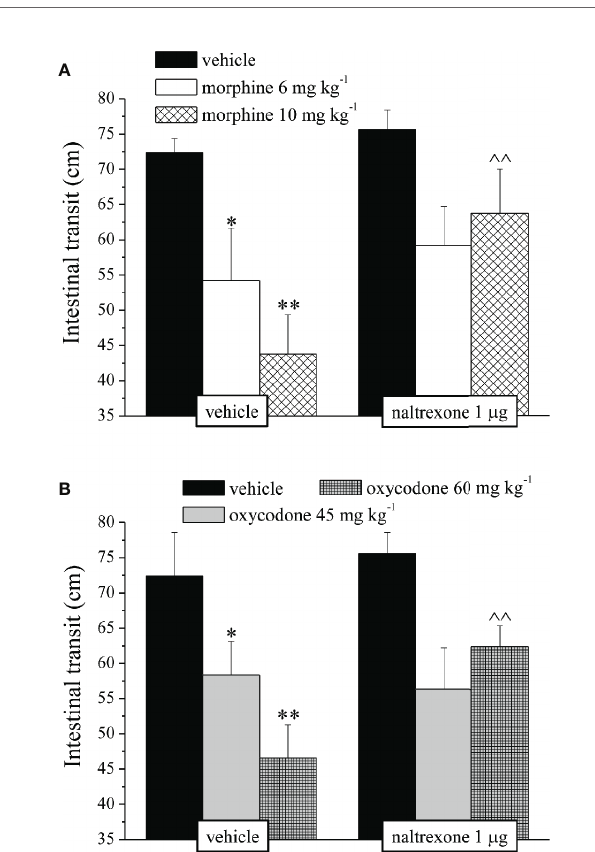
FIGURE 5 | Effect of intranasal administration of naltrexone on morphine and oxycodone induced inhibition of colonic propulsion in the mouse. The propulsion of the distal colon was evaluated by inserting a bead of glass in the distal colon of each animal 30 min after the administration of (A) morphine 10 mg kg − 1 or (B) oxycodone 60 mg kg − 1 . Naltrexone 1 m g was intranasally administered 30 min before the intraperitoneal injection of the opioids. Control animals were treated with vehicles. Each value represents the mean of 10 mice per group, performed in two different experimental sets. **P < 0.01 vs vehicle-treated animals; ^P < 0.05 vs morphine or oxycodone-treated